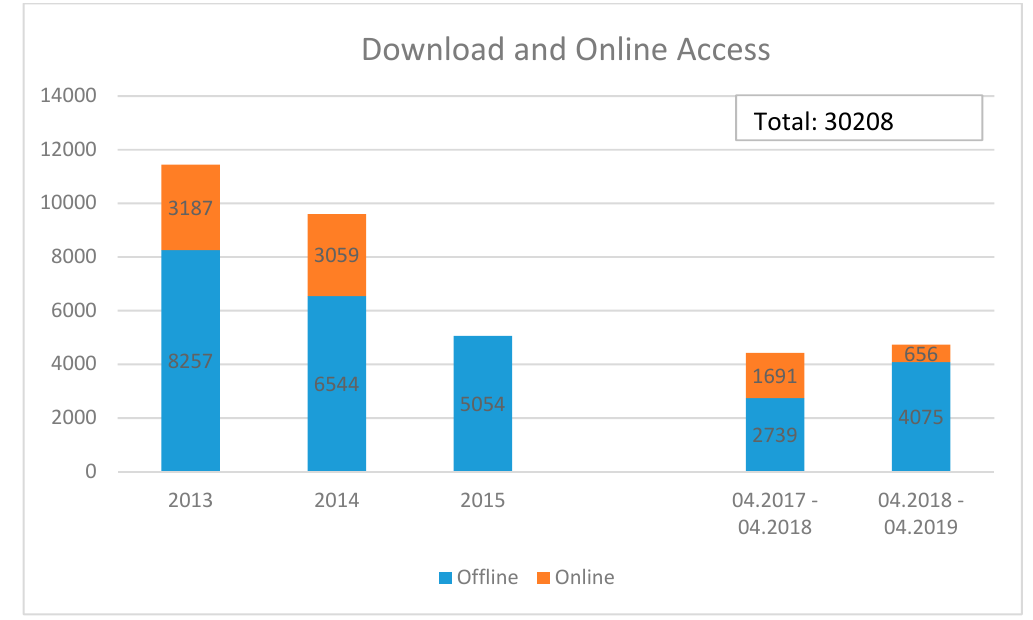
Figure 11. Accumulated module access and download.